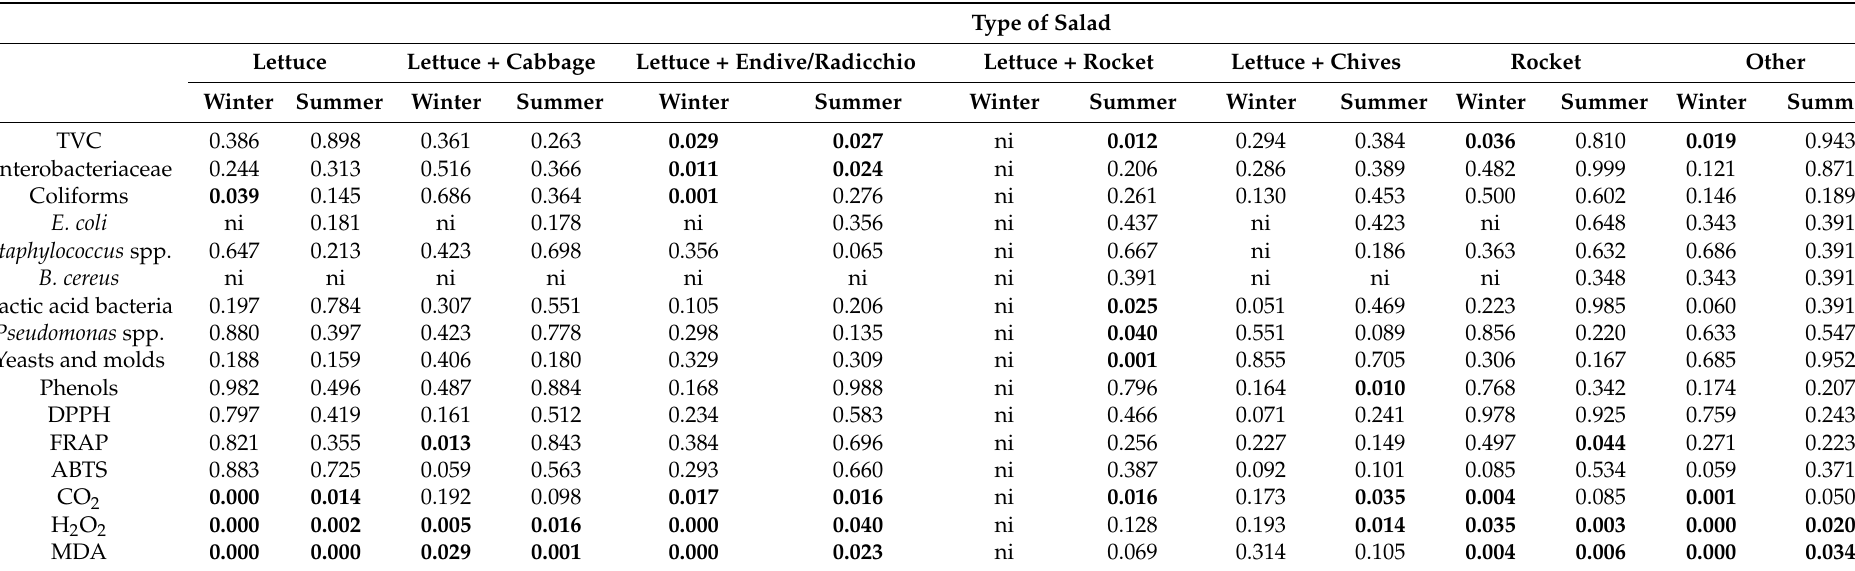
Table 4. Effect of shelf life on microbiological load (log cfu/g), total phenolic content (mg GAE/g Fw), antioxidants (mg Trolox/g Fw), % CO 2 and stress markers—H 2 O 2 ( µ mol/g Fw) and MDA (nmol/g Fw) of ready-to-eat salads according to the type of salad in winter and summer.